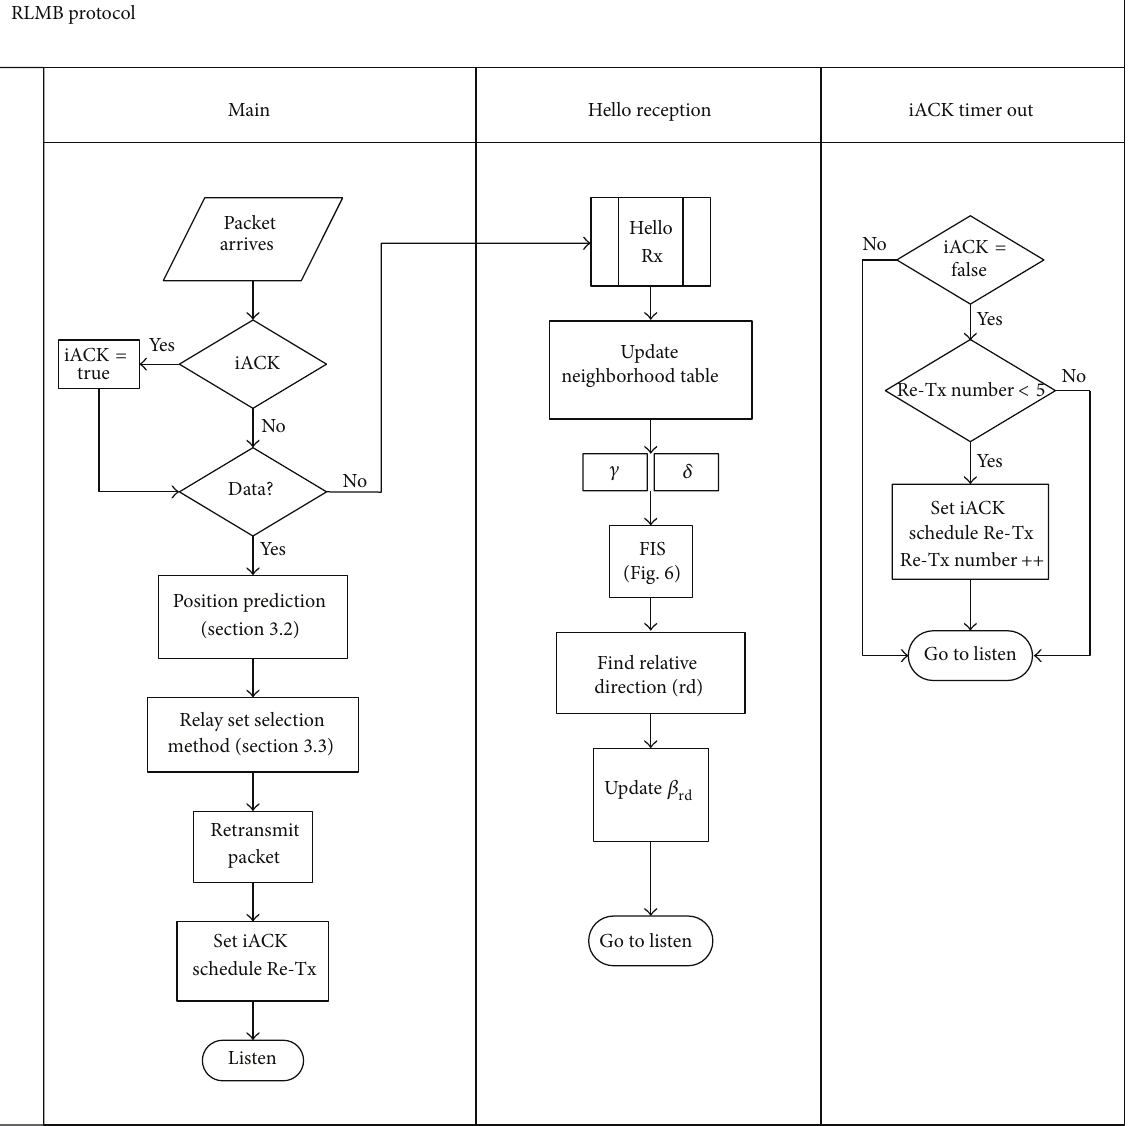
Figure 7: Flowchart of the main processes of RLMB broadcast